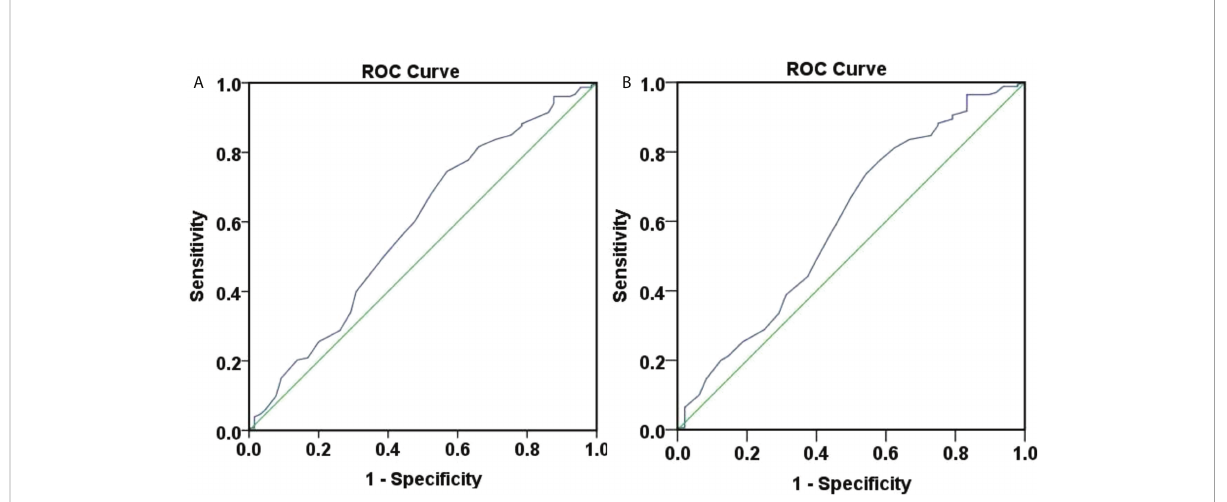
FIGURE 4 ROC curve of 48-weeks HBsAg clearance and seroconversion predicted by baseline age. (A) ROC curve of 48-weeks HBsAg clearance predicted by baseline age, the area under the curve was 0.586, 95% CI (0.500, 0.671), with poor accuracy. The optimal cut-off value for age was 40.5 years, the Youden index was 0.176, the sensitivity was 0.745, and the speci fi city was 0.431. When the sensitivity was 95%, the age was 30.5 years, and when the speci fi city was 95%, the age was 54.5 years. (B) ROC curve of 48-weeks HBsAg seroconversion predicted by baseline age, the area under the curve was 0.597, 95% CI (0.501, 0.692), with poor accuracy. The optimal cut-off value for age was 40.5 years, the Youden index was 0.193, the sensitivity was 0.735, and the speci fi city was 0.458. When the sensitivity was 95%, the age was 30.5 years, and when the speci fi city was 95%, the age was 53.5